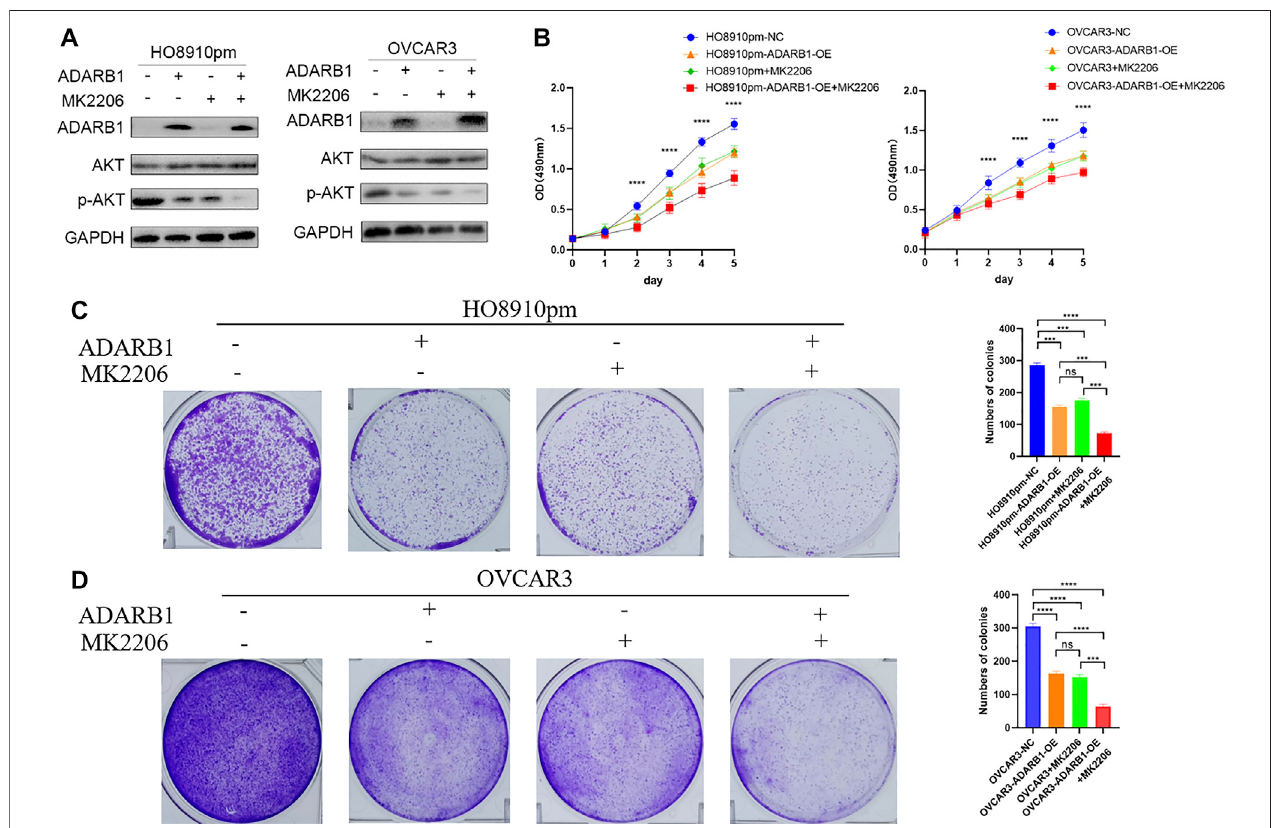
FIGURE 5 | AKT pathway was involved in ADARB1-reduced cell proliferation. (A) HO8910pm and OVCAR3 cells treated with ADARB1-OE and/or AKT inhibitors MK2206 subjected to Western blot assays. (B) The MTT assay were performed after HO8910pm and OVCAR3 cells treated with ADARB1-OE and/or AKT inhibitors MK2206. (C,D) The colony formation assay were performed after HO8910pm and OVCAR3 cells treated with ADARB1-OE and/or AKT inhibitors